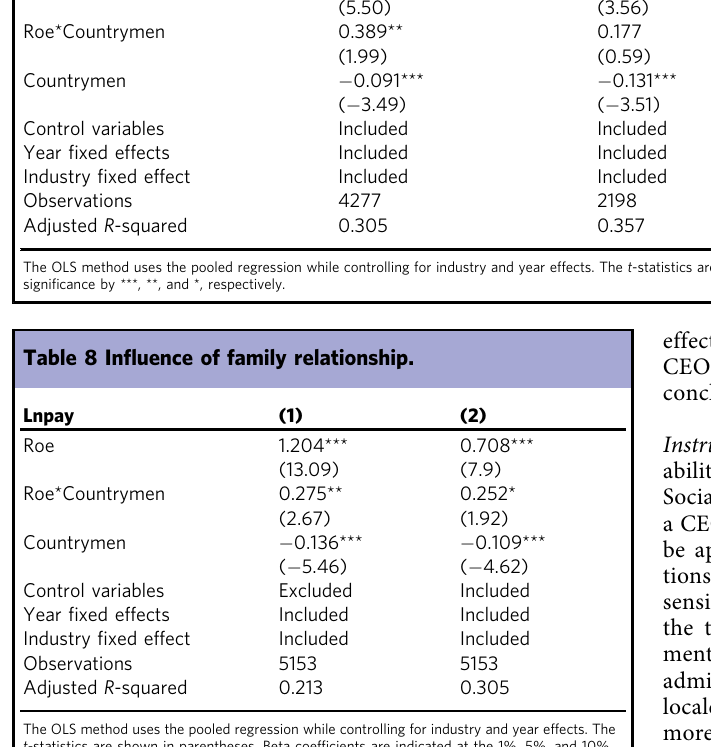
The OLS method uses the pooled regression while controlling for industry and year effects. The t -statistics are shown in parentheses. Beta coef fi cients are indicated at the 1%, 5%, and 10% levels of signi fi cance by ***, **, and *,